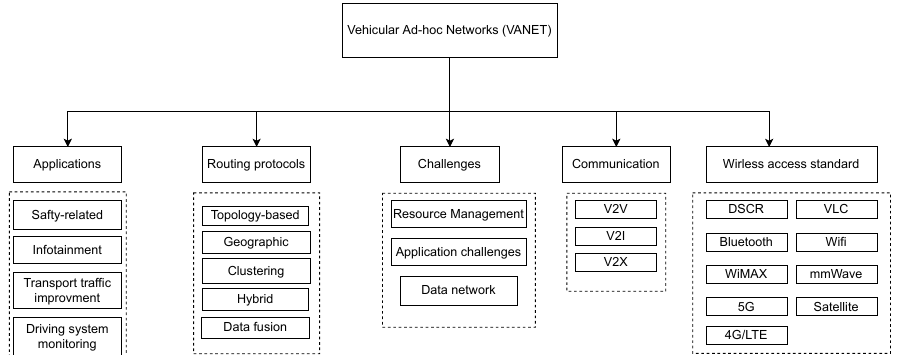
Figure 2. General Operation of